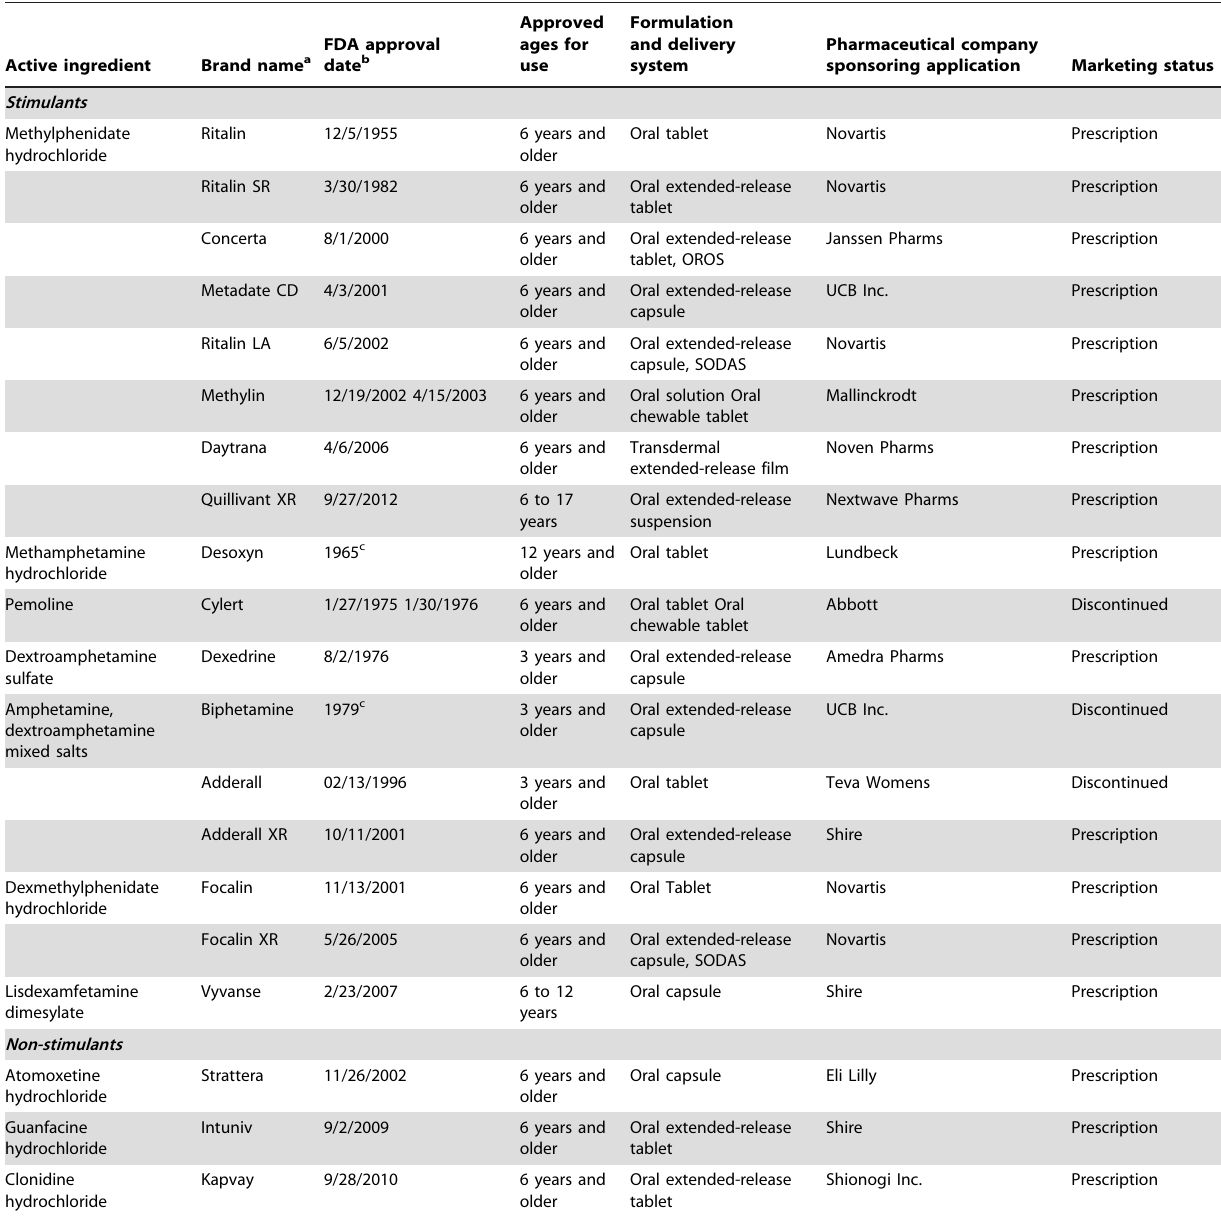
Table 1. Medications approved by the FDA for the treatment of ADHD.